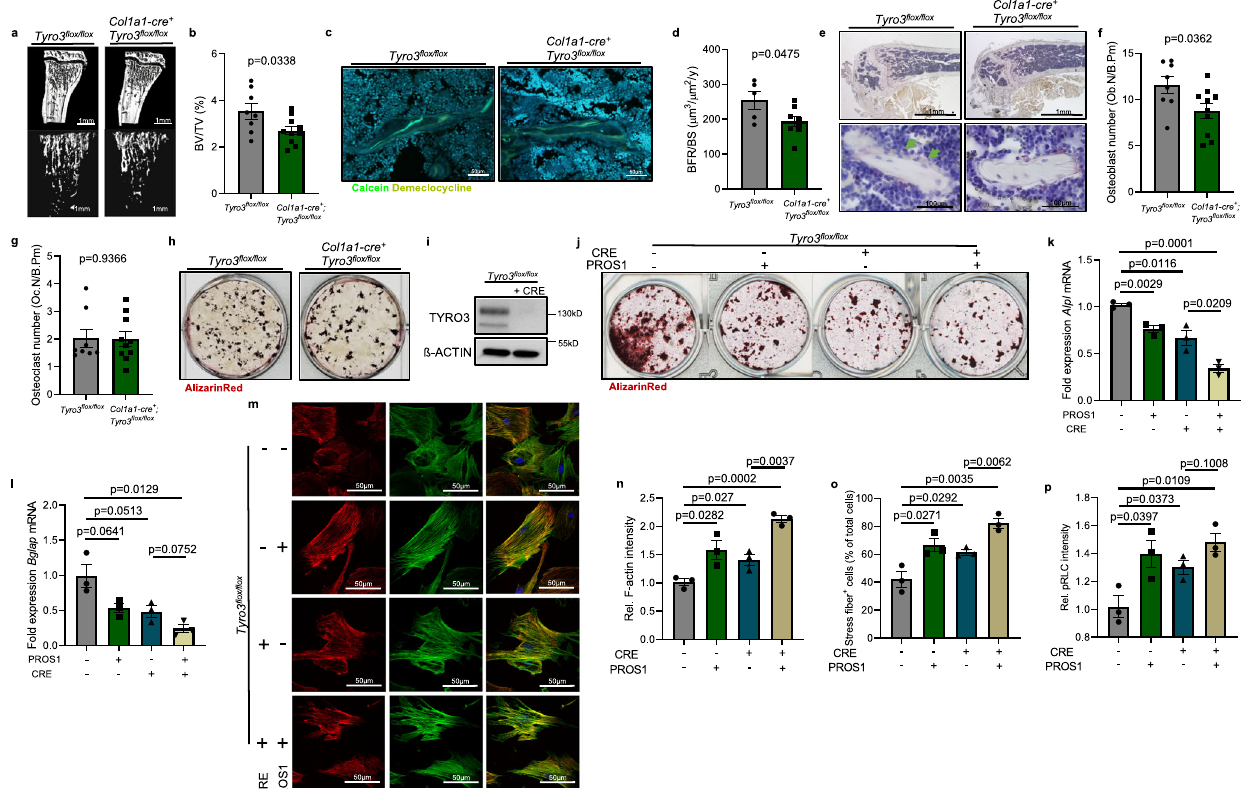
Fig. 3 | TAM receptor TYRO3 promotes osteoblastogenesis and bone forma- tion. a , b Microcomputed tomography ( μ CT) of the metaphyseal proximal region of tibias from 8-week-old Tyro3 fl ox/ fl ox and Col1a1-cre + ; Tyro3 fl ox/ fl ox female mice (top, long- itudinalviewof corticalandcancellousbone;bottom,longitudinalview ofcancellous bone) ( a ). Quanti fi cation of bone volume ( b ) of cancellous bone determined by μ CT analysis ( Tyro3 fl ox/ fl ox , n =8; Col1a1-cre + ; Tyro3 fl ox/ fl ox , n =10). c , d Representative pictures of Calcein Demeclocycline labeling of Tyro3 fl ox/ fl ox and Col1a1-cre + ; Tyro3 fl ox/ fl ox female mice ( c ). Bone formation rate of Col1a1-cre + ; Tyro3 fl ox/ fl ox mice after 8weeks( Tyro3 fl ox/ fl ox , n =5; Col1a1-cre + ; Tyro3 fl ox/ fl ox , n =8) ( d ). e – g Representative pictures ( e ) of histomor- phometric analysis of osteoblast ( f ) and osteoclast number ( g ) by TRAP/Hematoxylin staining in femur from Col1a1-cre + ; Tyro3 fl ox/ fl ox mice. Green arrows pointing to osteo- blasts visible as cuboidal or polygonal mononuclear cells on the endosteal bone